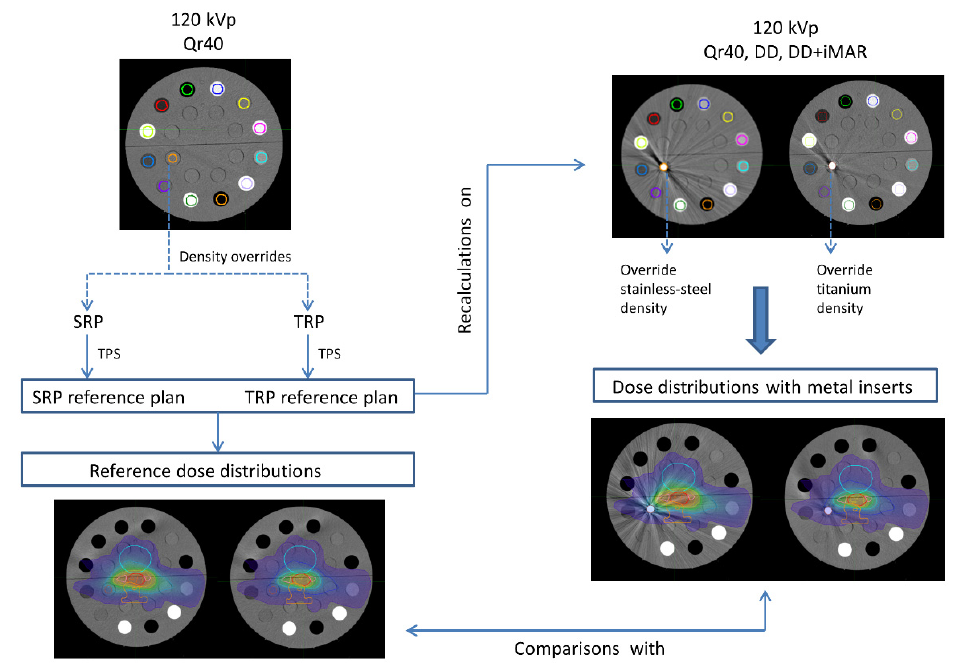
Figure 5. A representative scheme of the dose calculation procedure.